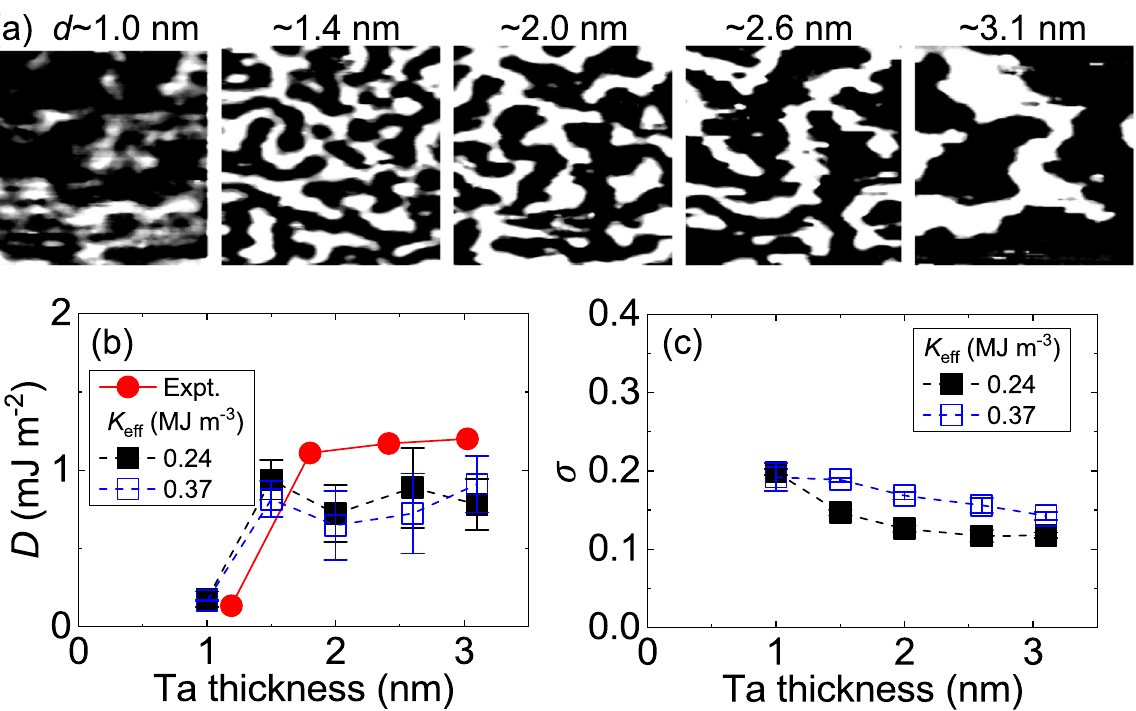
Fig. 4 D and σ obtained from pattern recognition and machine learning. a Experimentally obtained magnetic domain images using a magnetic microscope equipped with a MTJ sensor. The bright and dark contrast represent magnetization pointing from and into the paper. The thickness of the Ta seed layer ( d ) is denoted in each image. b , c DM exchange constant ( D ) ( b ) and distribution of K u ( σ ) ( c ) estimated from the domain images using the trained system. Two different values of K eff are used in the simulations to generate the training images: the estimated values ( D and σ ) obtained from the trained systems are denoted using open and solid squares. The error bars show 95% con fi dence interval (see “ Methods ” ). D from Fig. 3c is shown together by the red circles in ( b